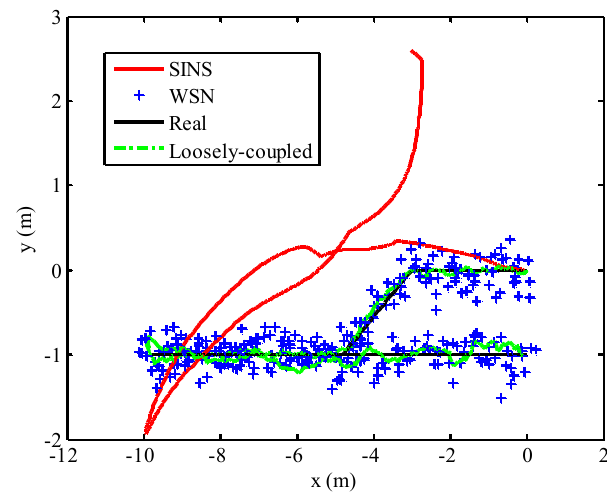
Figure 12. Positioning performance using SINS/WSN loosely-coupled integration model.